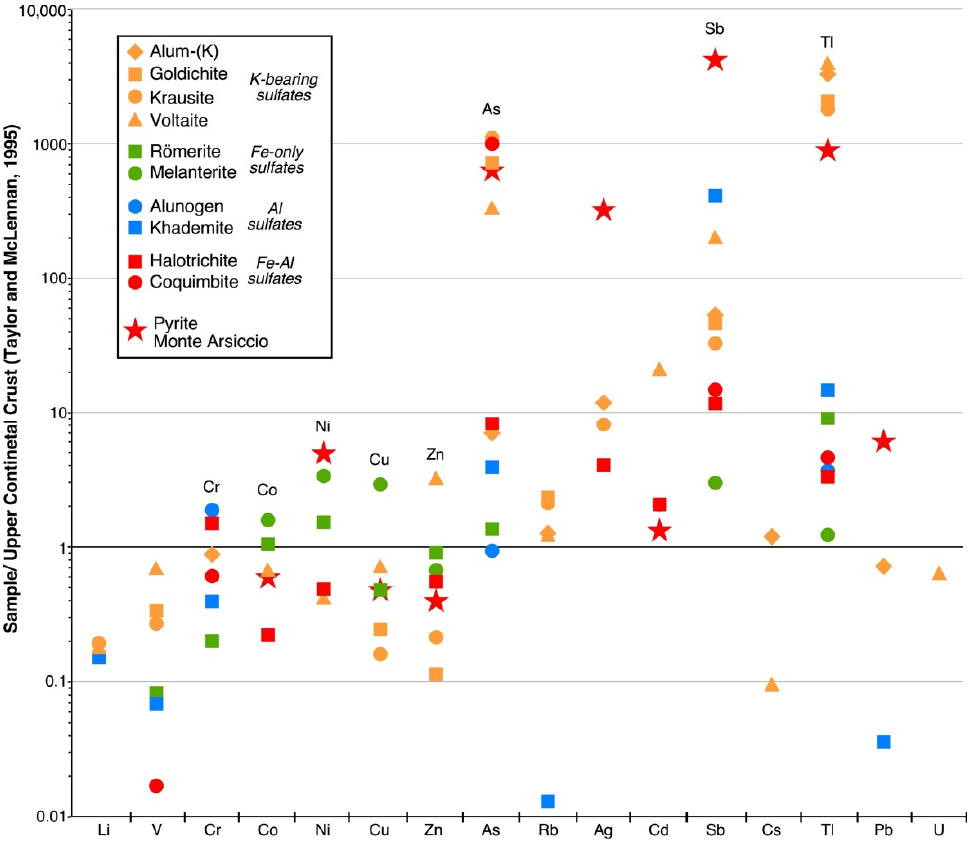
Figure 5. Concentrations of trace elements in the studied sulfates normalized to the Upper Continental Crust values of Taylor and McLennan [40]. Red stars represent the average values of 135 spot analyses by LA-ICP-MS of the Monte Arsiccio pyrite, taken from George et al. [9].